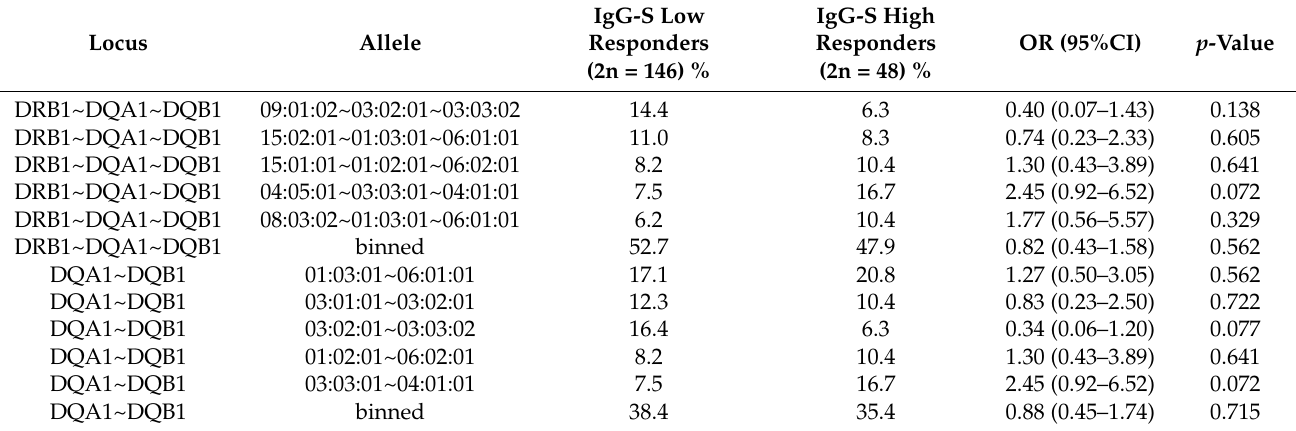
Table 3. HLA haplotype analysis for HLA-DRB1, -DQA1, and -DQB1 in IgG-S low responders versus high responders. Abbreviations: OR, odds ratio; 95%CI, 95% confidence Interval; binned, rare HLA alleles with expected count <5 are combined into a common